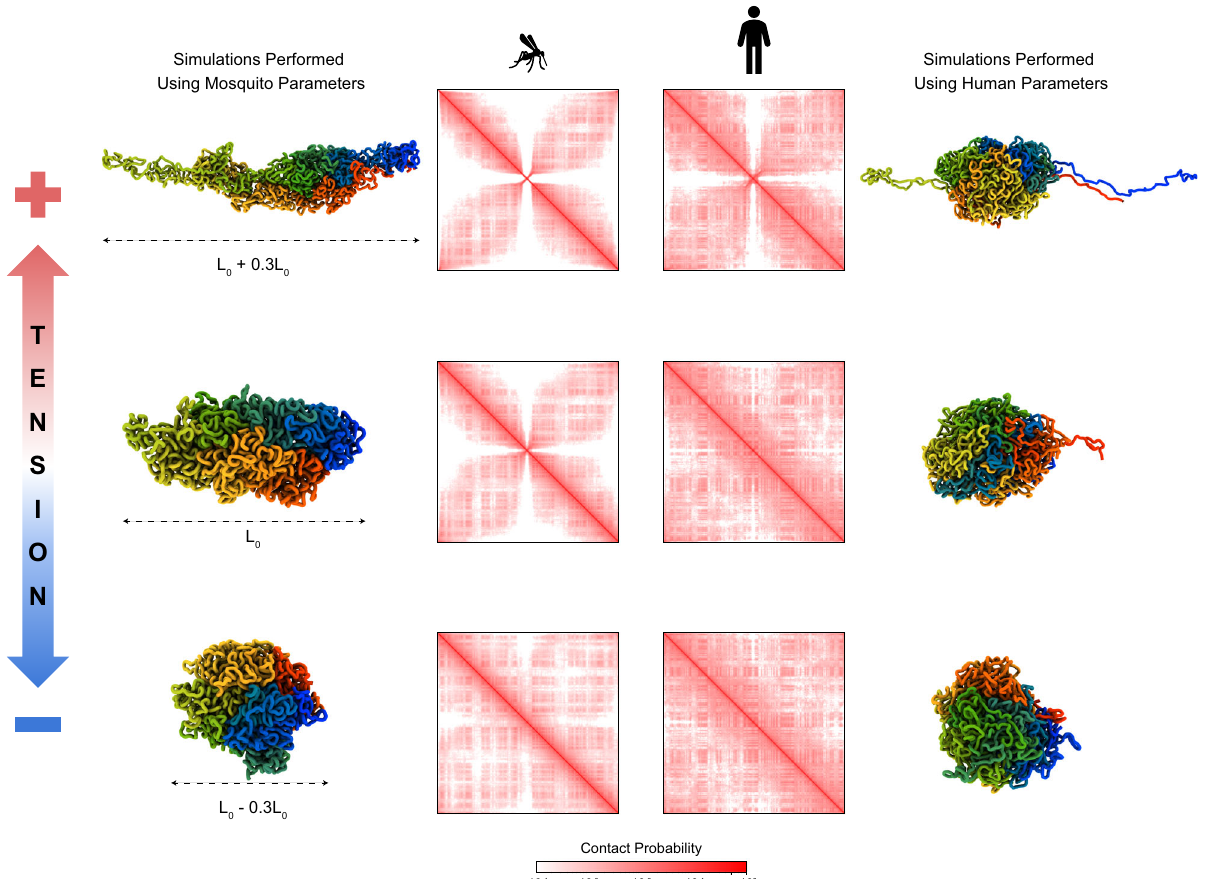
alongsidetheinsilicoHi-Cmaps.Thetoppanelspresentthecentromere-telomeres separation distance L + , 30% bigger than L 0 that is presented in the middle. At the bottomispresent thecasewherethe separationdistance L − is30% smallerthan L 0